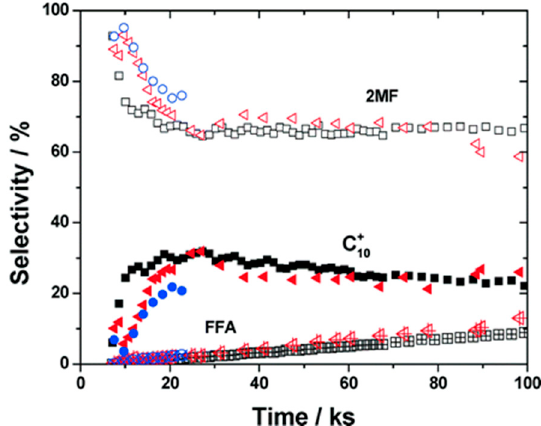
Figure 10. Furfural hydrodeoxygenation product selectivity as a function of time on Mo 2 C catalysts: 2-methylfuran (2MF), C 10+ , and furfuryl alcohol (FFA). Fresh Mo 2 C catalyst ( □ , ■ , ⊞ ) and the same catalyst after the first ( ) and second ( ) regeneration cycle. Reproduced with permission from [32]. Copyright The Royal Society of Chemistry, 2014.